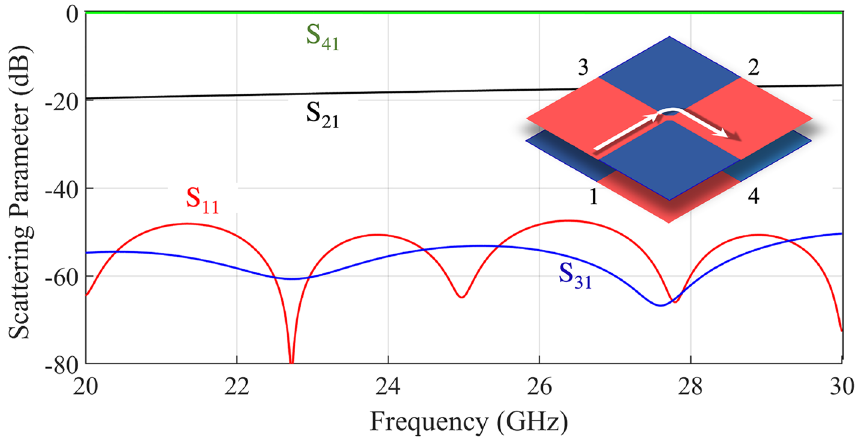
Figure 2. Simulated scattering parameters of the ideal 4-ports junction shown in Fig. 1c.